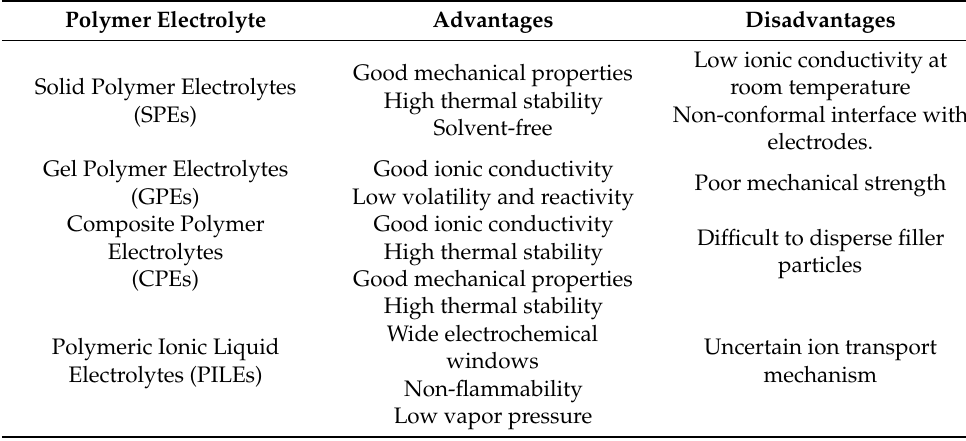
Table 2. Comparison of various types of polymer electrolytes.